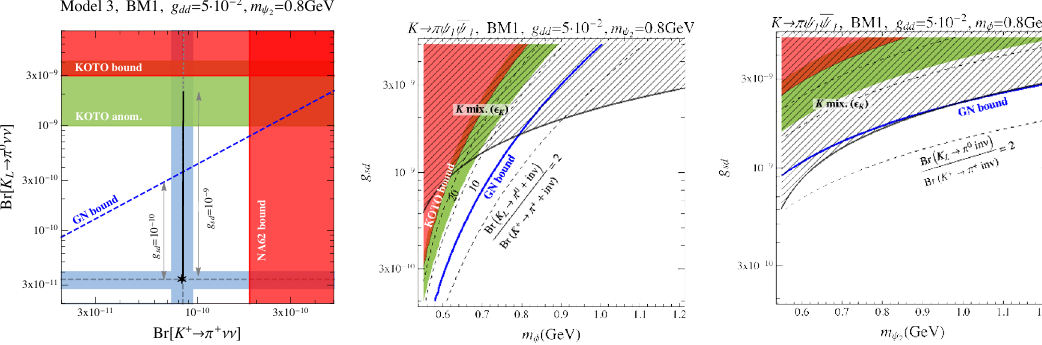
Figure 19 . The parameter space for Model 3, BM1, eq. (5.9). The color coding is the same as